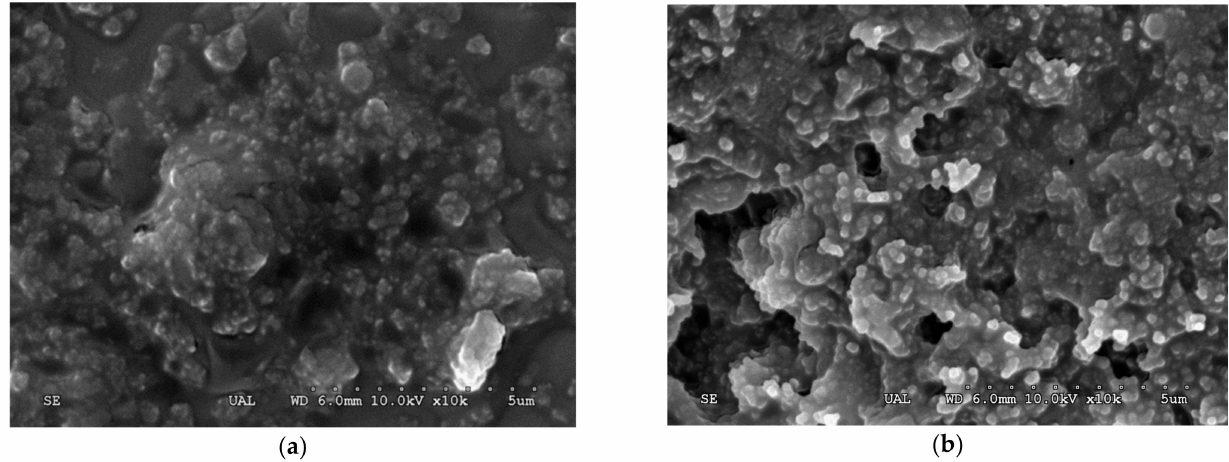
Figure 2. Scanning electron microscopy (SEM) images of cross-linked enzymatic aggregates (CLEAs) prepared at pH 6.5 ( a ) and pH 8.5 ( b